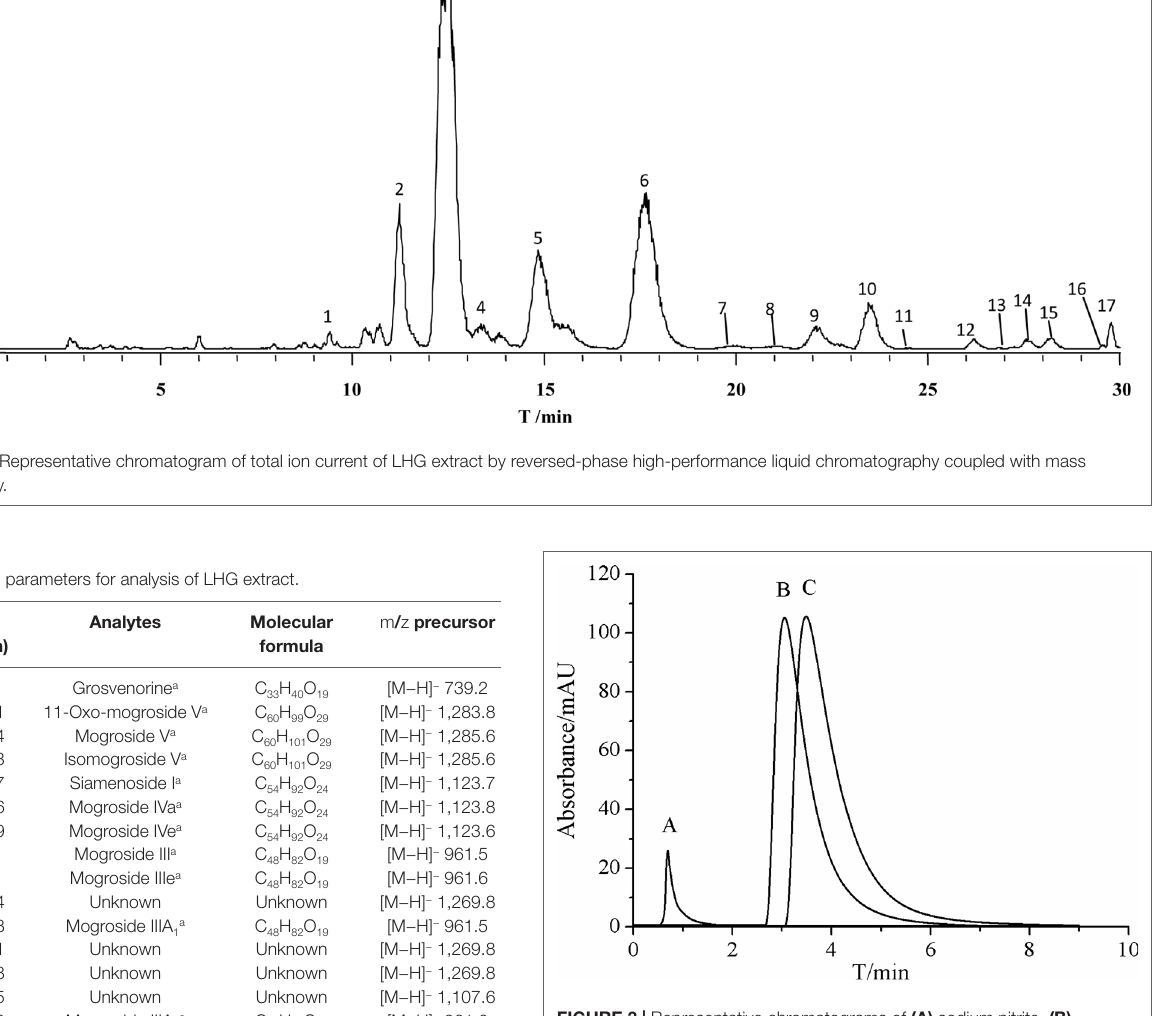
FIGURE 3 | Representative chromatograms of (A) sodium nitrite, (B) salbutamol, and (C) terbutaline on immobilized β 2 -AR column by high- performance liquid